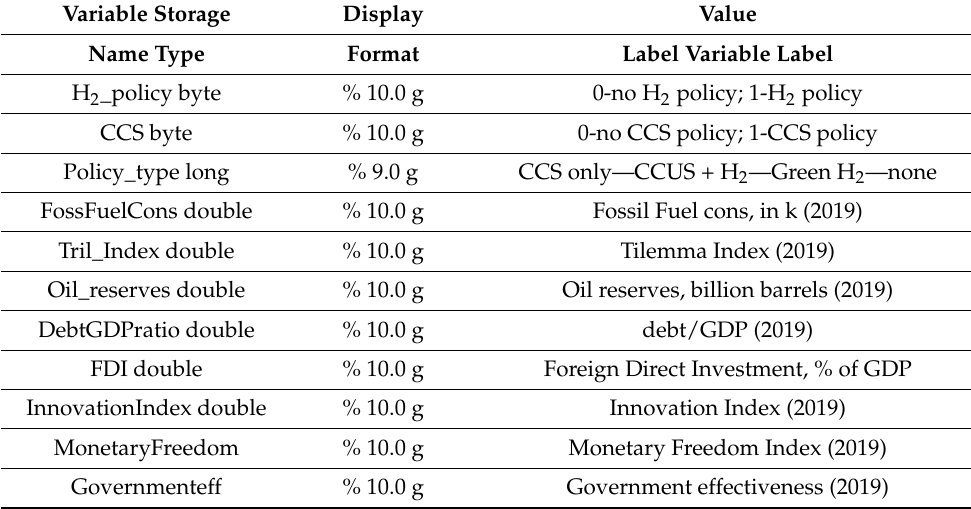
Table 2. Variable summary.